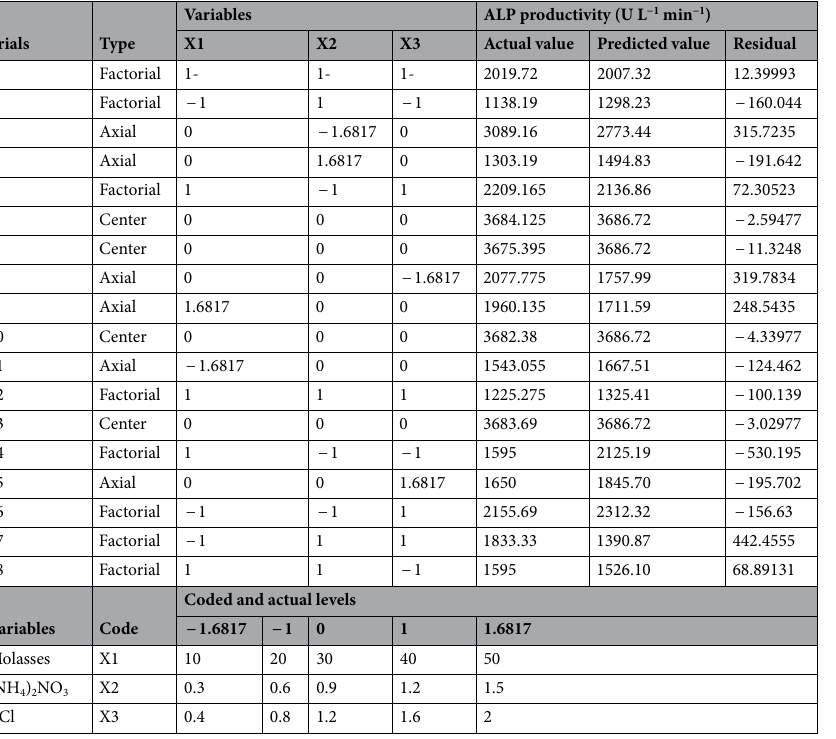
Table 3. Matrix designed for Bacillus paralicheniformis strain APSO